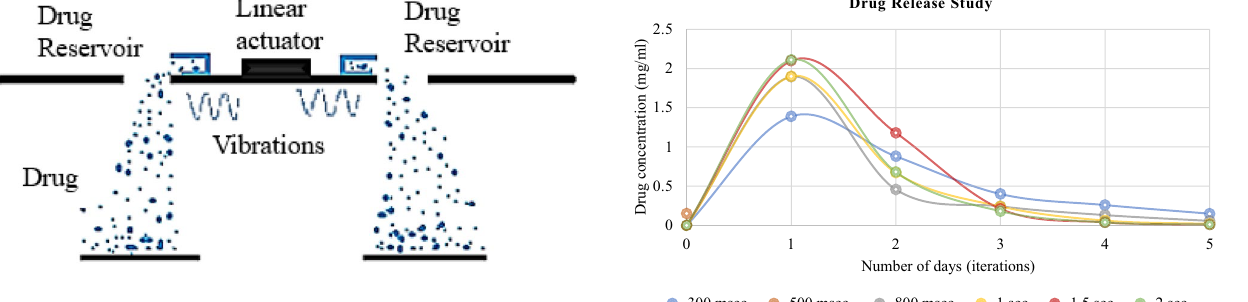
Fig. 7 Mechanism of drug release from the device upon actuator vibration (side view)